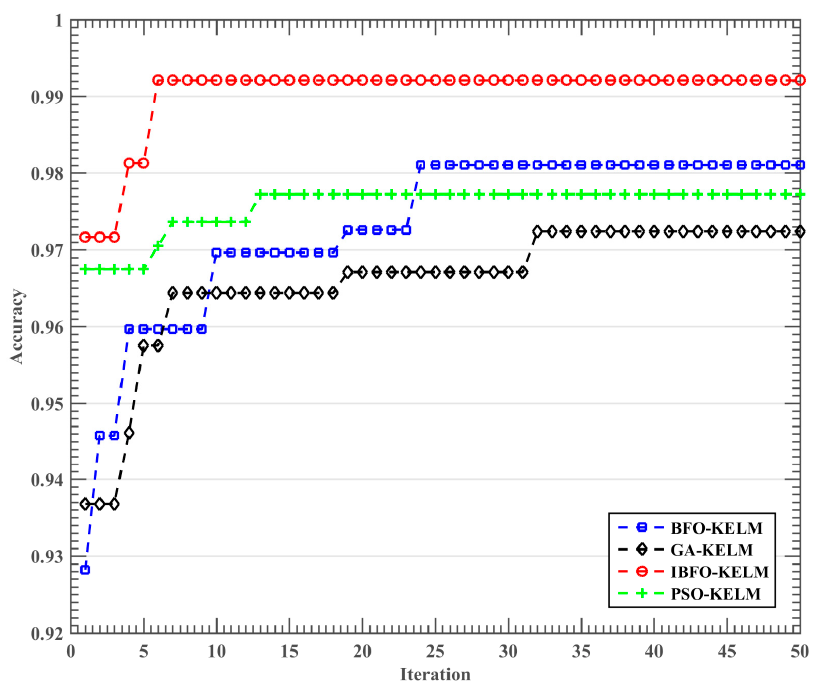
Figure 4. Relationship between the iteration and training accuracy of improved bacterial foraging optimization based KELM (IBFO-KELM), bacterial foraging optimization (BFO-KELM), particle swarm optimization based KELM (PSO-KELM) and genetic algorithm